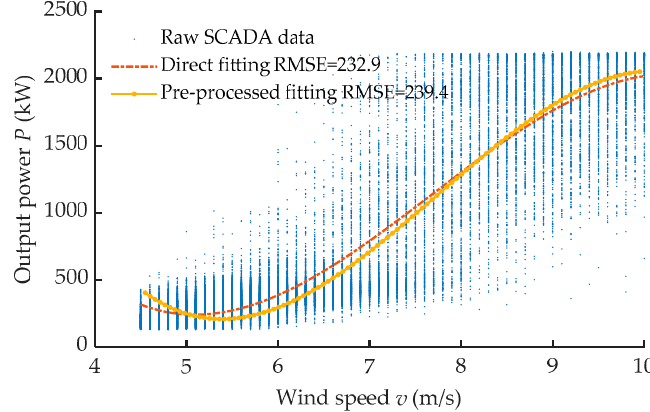
ff erent fitting methods for wind speed and Figure 14. Comparison of different fitting methods for wind speed and power. Figure 14. Comparison of di Figure 14. Comparison of different fitting methods for wind speed and power.